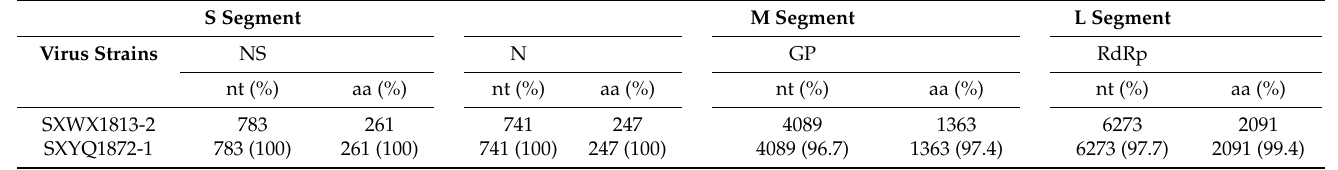
Table 2. Identities analysis of the ORF of WUXV SXWX1813-2 and SXYQ1872-1.